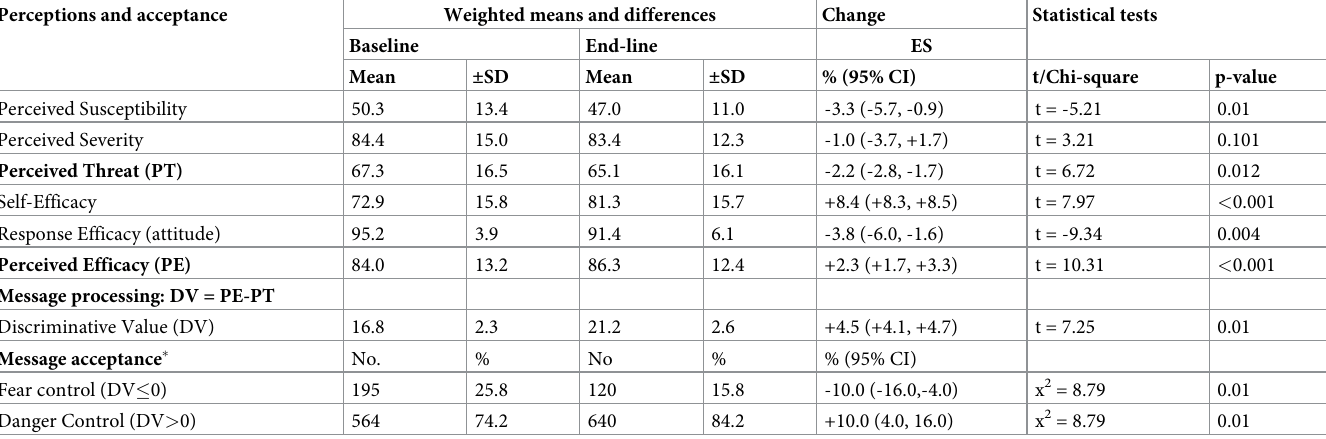
Table 5. Community malaria message processing and acceptance, Jimma Zone, SBCC target districts, 2017–19 (Baseline = 762, End-line =